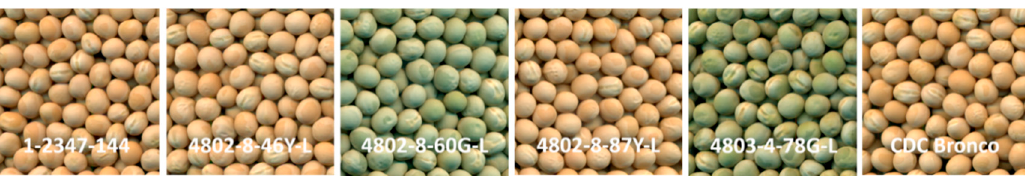
Figure 1. High-resolution photographs depicting six varieties used to evaluate the iron bioavailability of the Saskatchewan peas. To compare the differences in seed sizes, all photographs were taken to scale under standardized lighting conditions.